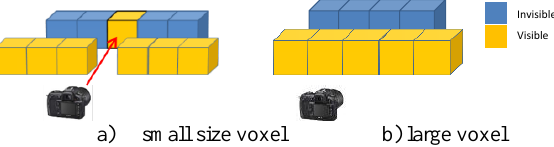
Figure 8. Improper visibility of sparse points represented by